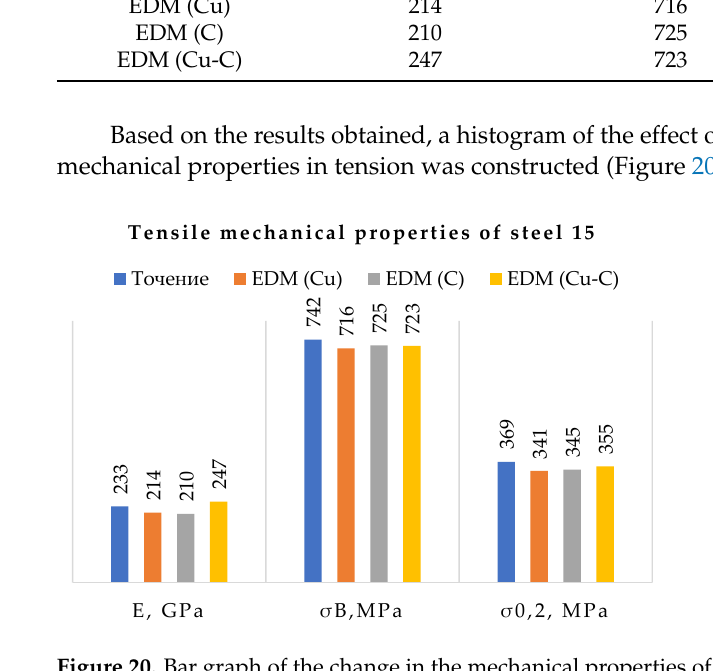
Figure 20. Bar graph of the change in the mechanical properties of steel 15 under tension.